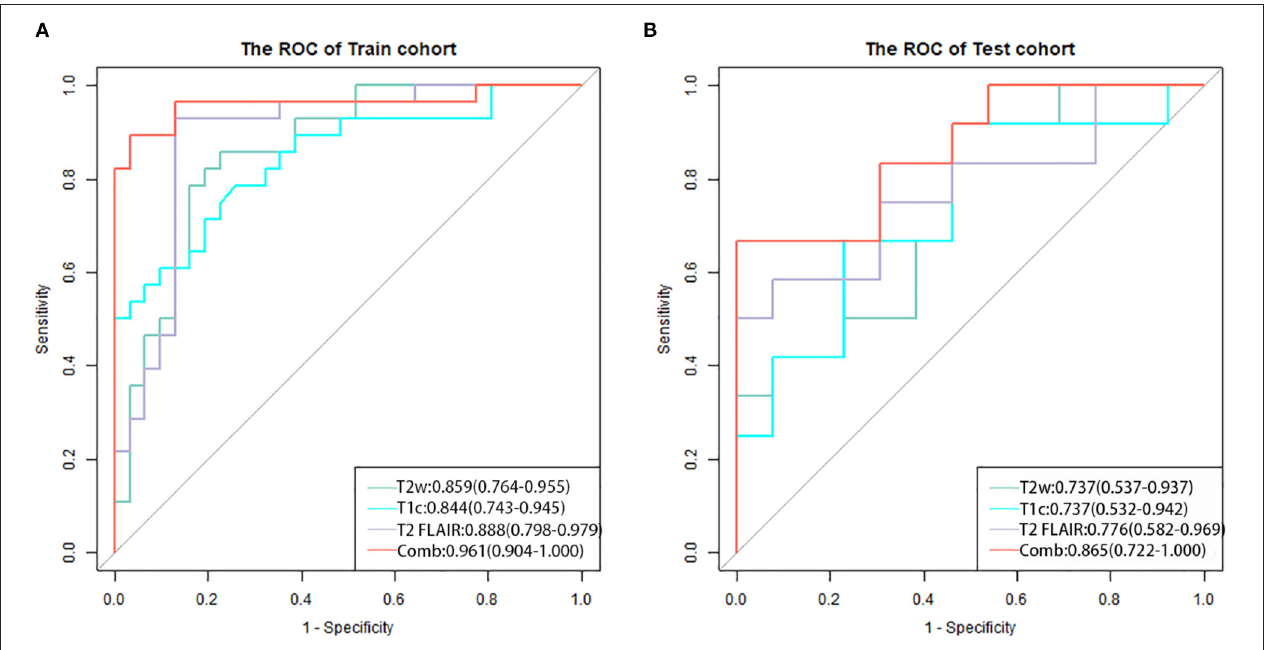
FIGURE 4 | The receiver operating characteristic curves of the four models for the training (A) and test (B) cohorts. The combined model (red line) applied to the training and test cohorts had the best performance.